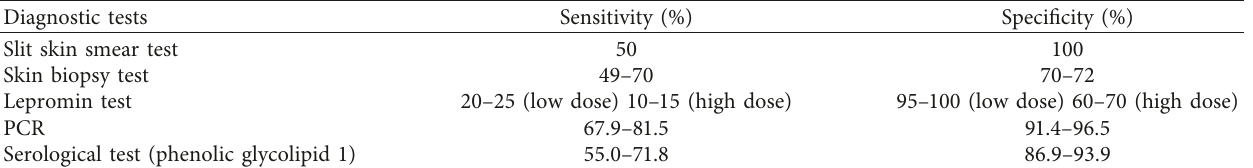
Table 2: Comparisons between the sensitivity and specificity among the various diagnostic tests for leprosy.